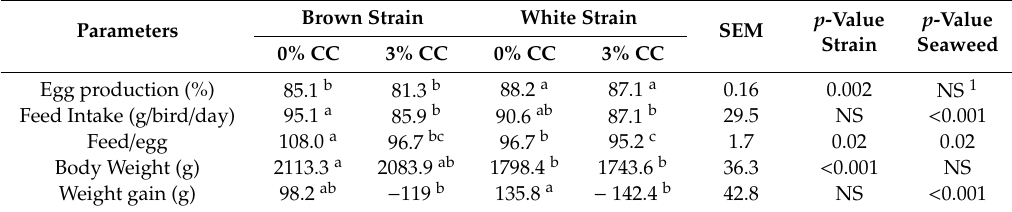
Table 2. E ff ects of strain and seaweed intake on the means and standard errors of layer hen performances in the short-term trial.